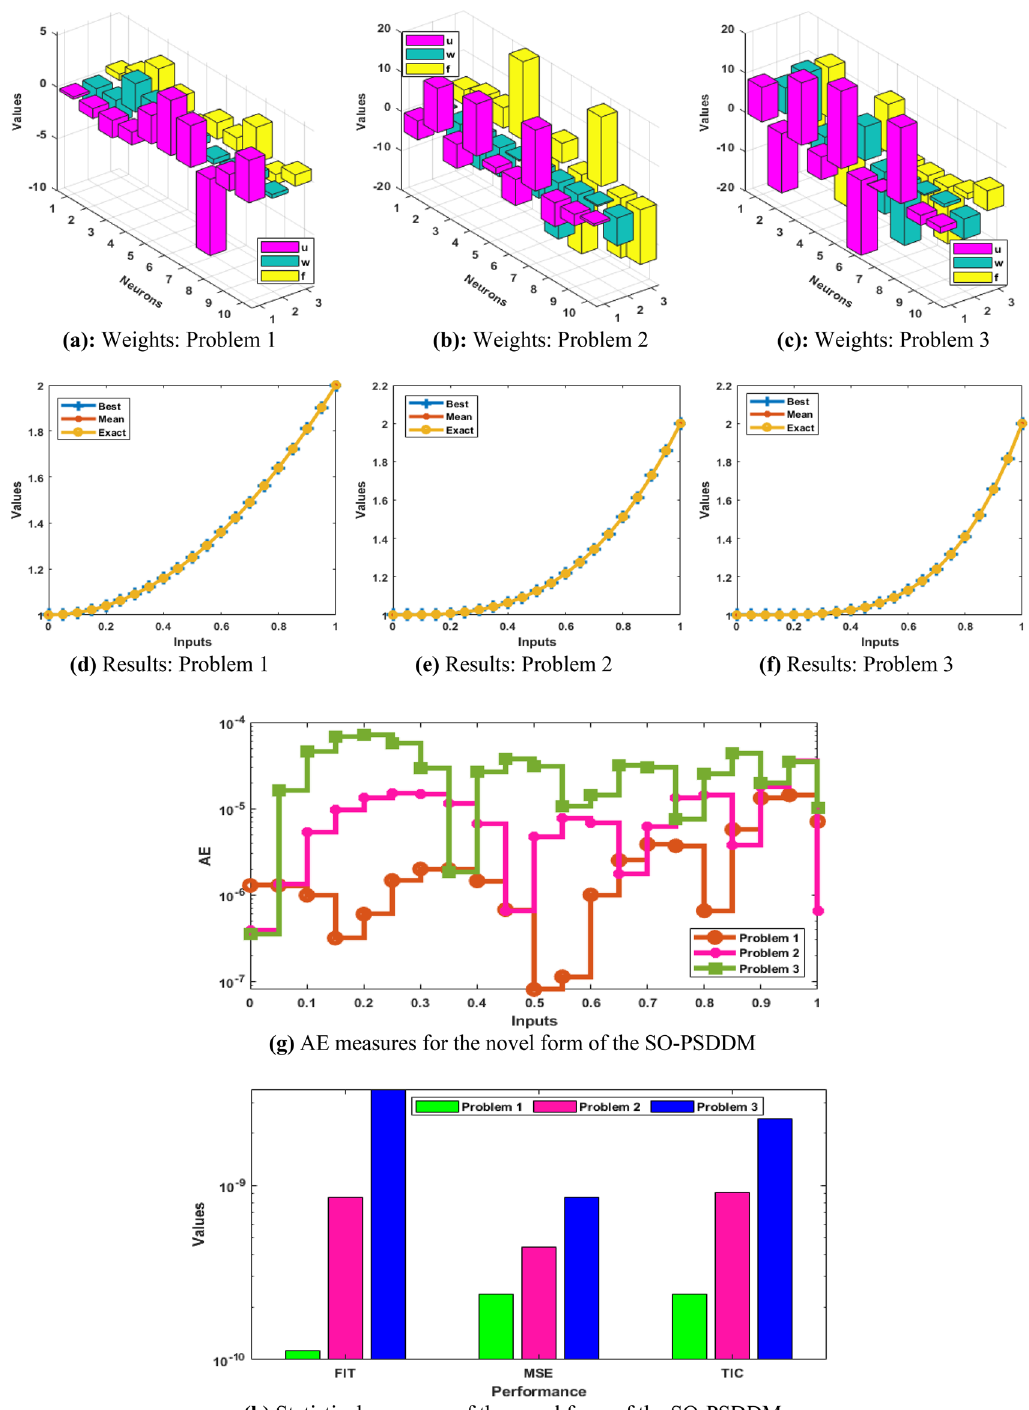
Figure 3. Graphic representations of optimal weight vectors, AE and statistical performances for solving the